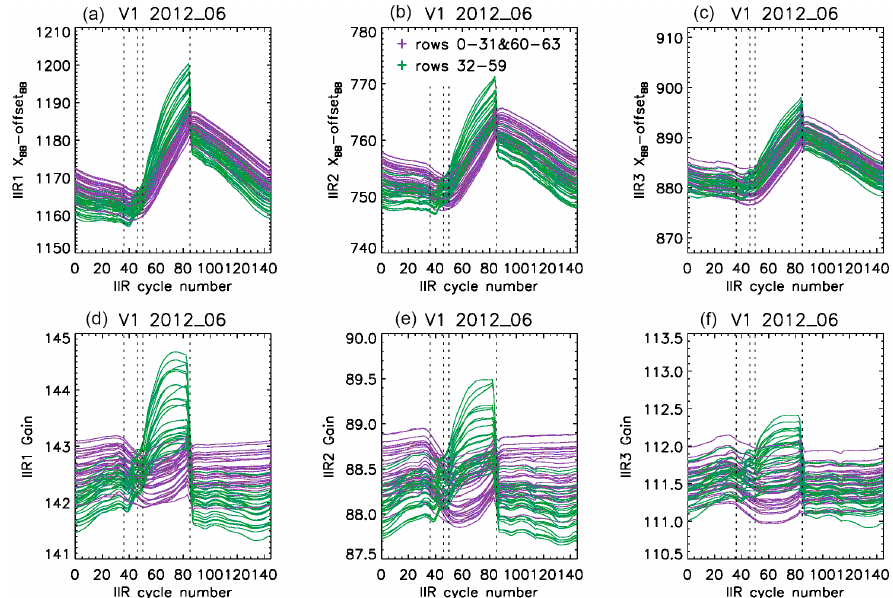
Figure 5. Mean digital counts in offset-corrected blackbody views (a–c) and resulting gains (d–f) vs. IIR cycle number in June 2012 for each of the 64 rows, showing a different behavior for the purple ( i = 0–31 and 60–63) and the green ( i = 32–59) rows. Digital counts and gain are plotted for the three channels: IIR1 (a, d) , IIR2 (b, e) , and IIR3 (c, f) .